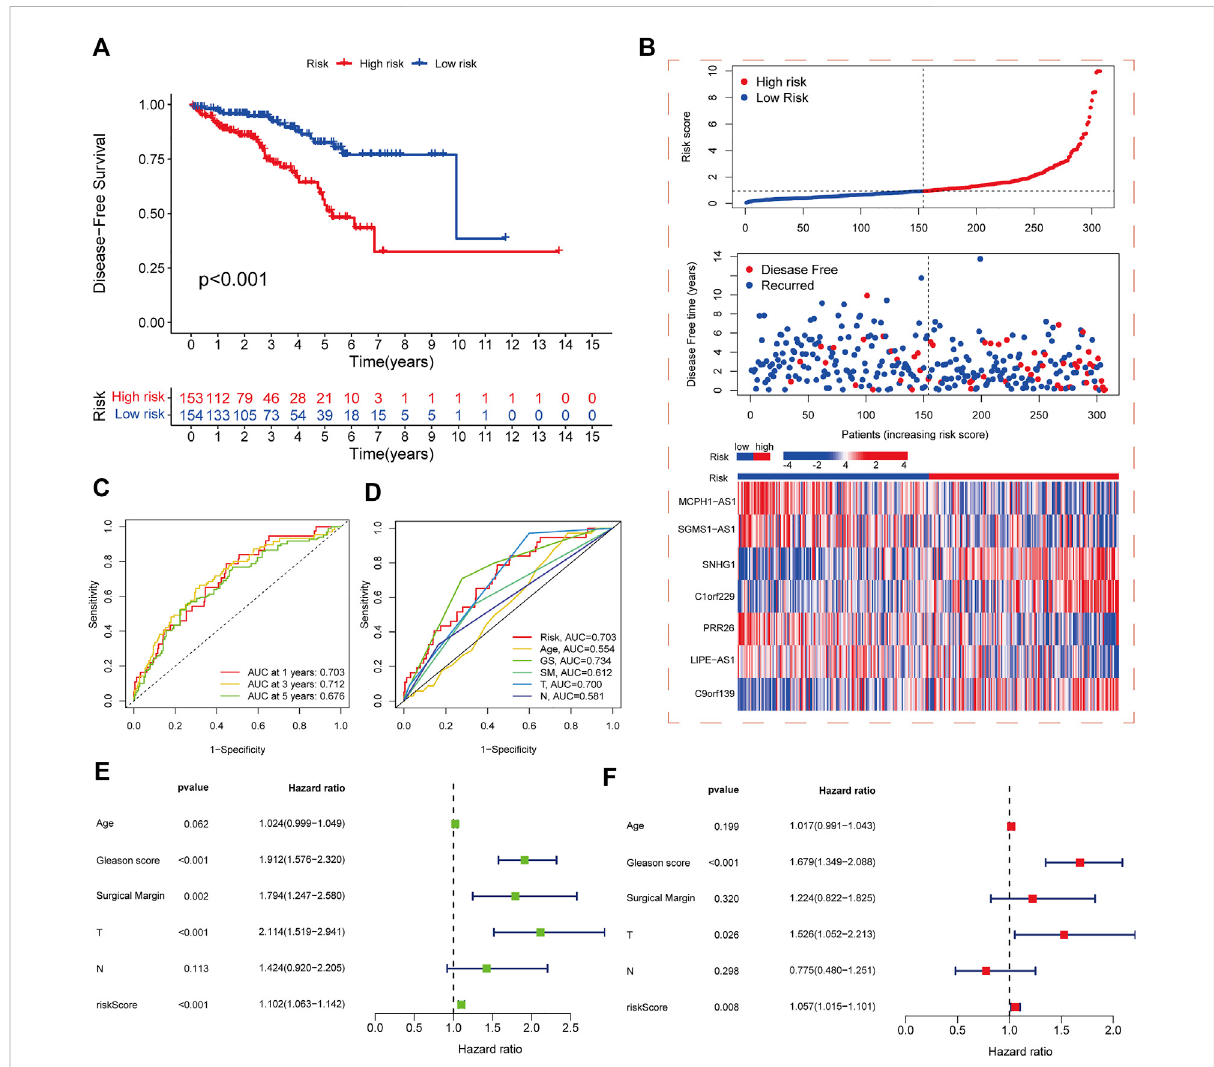
FIGURE 3 Development and validation of risk score model. (A) Kaplan-Meier analysis of DFS rates in high- and low-risk cohorts in the training set. (B) Risk score distribution, survival distribution, and heatmap of CRL expression for patients in high- and low-risk cohorts in the training set. (C) ROC curves for1-,3-,and5-yearDFSbasedontheriskscoremodelinthetrainingset. (D) ROCcurvesforriskscoreandotherclinicopathologicalcharacteristics based on DFS in PCa patients. (E) Forest plot of the associations between risk score and other clinicopathological characteristics by univariate Cox regression analysis. (F) Forest plot of the associations between the risk score and other clinicopathological characteristics by multivariate Cox regression